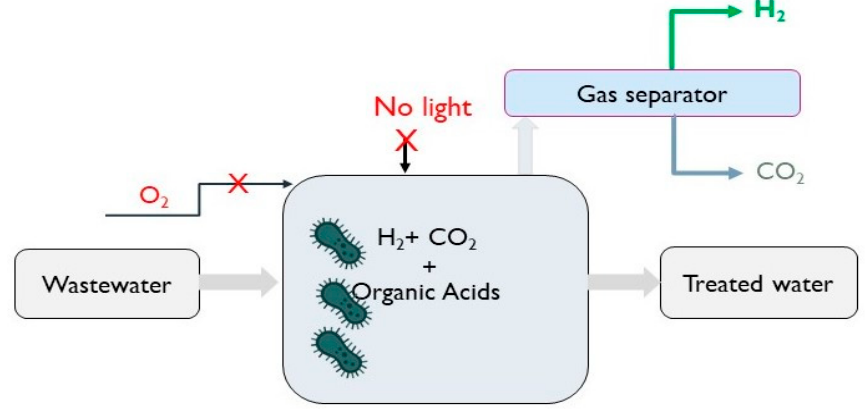
Figure 7. Schematic diagram of dark fermentative H 2 production process.